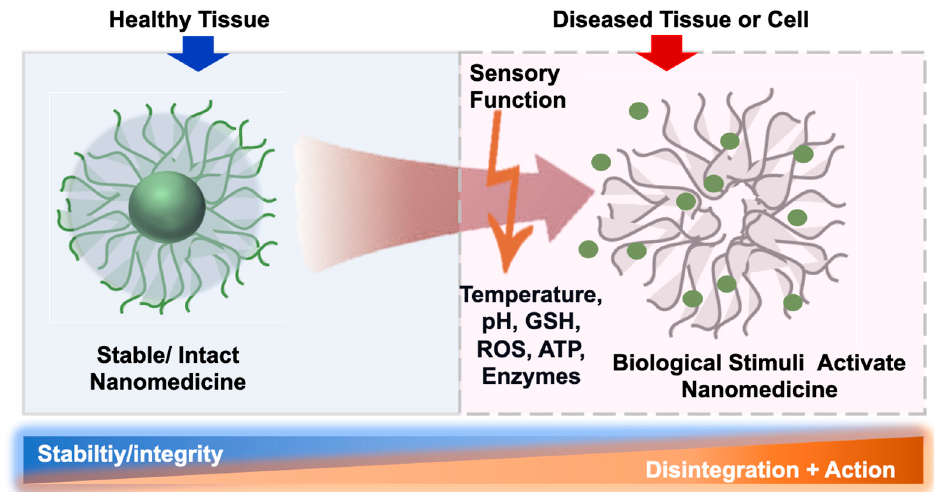
Figure 1. Schematic representation of nanomedicine’s bioresponsive and sensory functions.